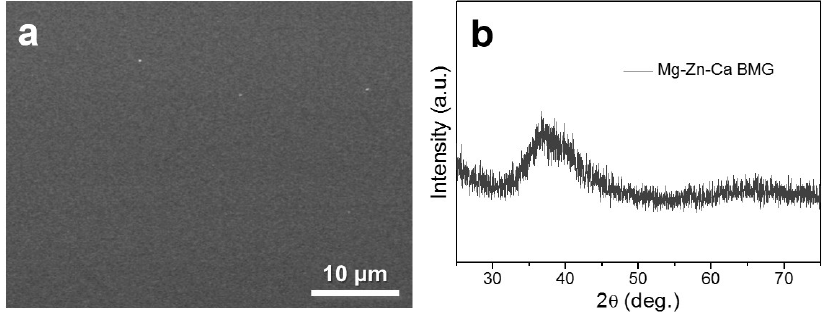
Figure 2. SEM image ( a ) and XRD patterns ( b ) of the original copper mold spray